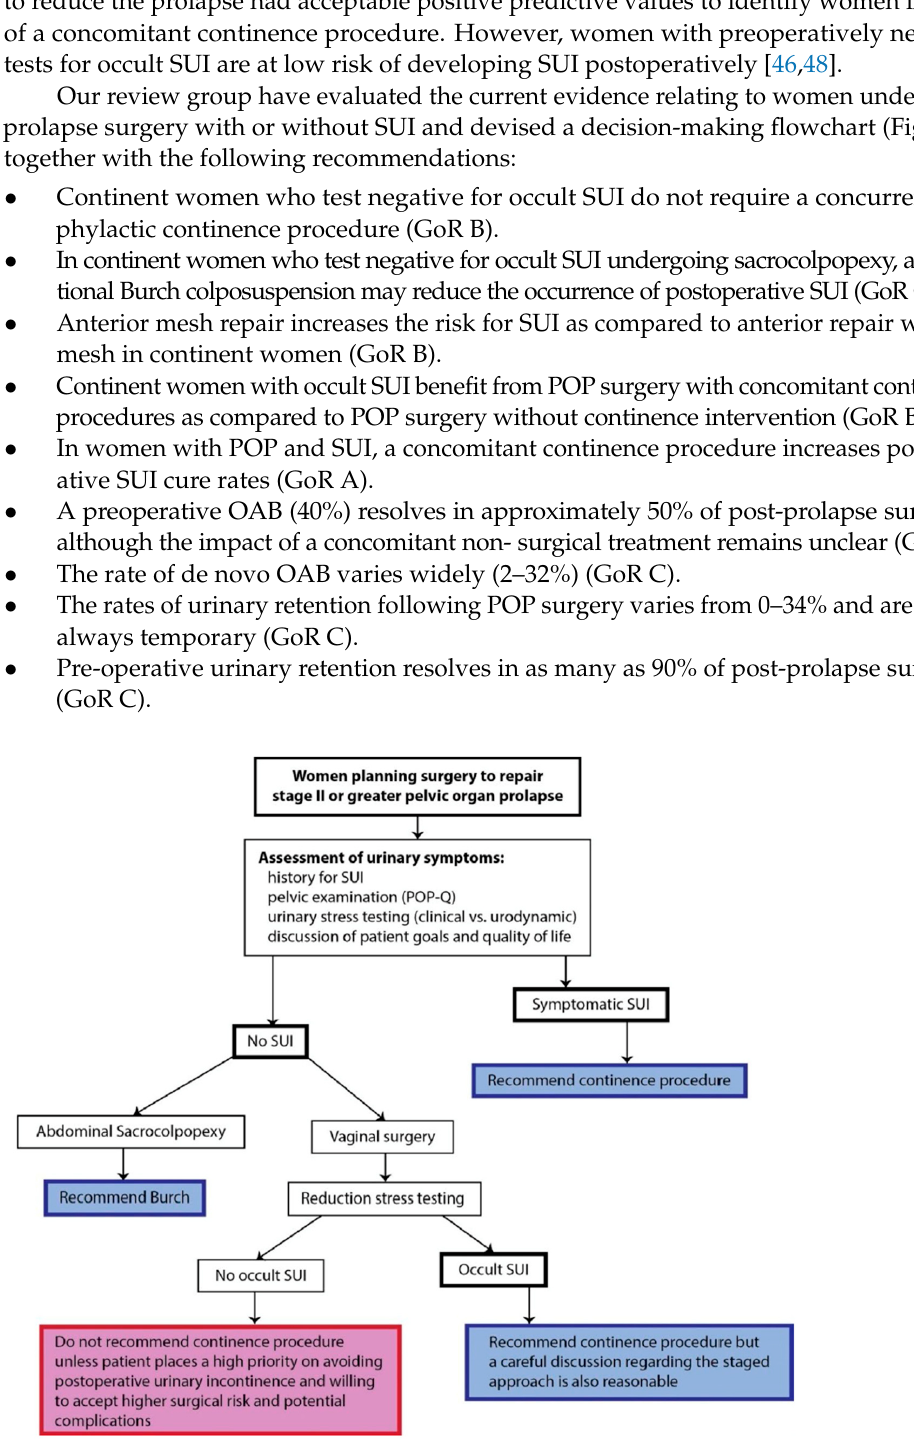
Figure 2. Decision-making flowchart for women undergoing prolapse surgery with or without SUI.